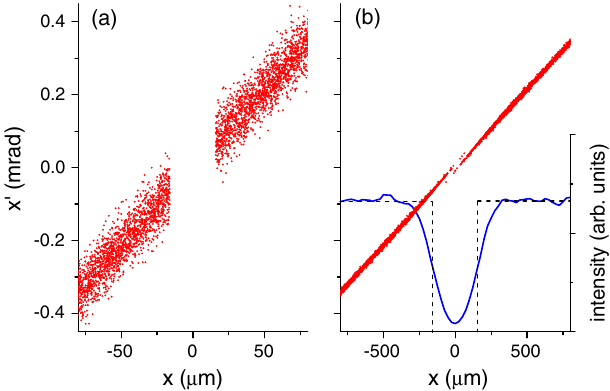
FIG. 6. Zoomed in snapshots of the x (cid:1) x 0 trace space of the beam (a) just blocked by a 32 (cid:1) m grid bar and (b) at the beam profile screen 2.1 m after the grid. In (a) the beam has a uniform density along x and a Gaussian distribution in x 0 with an rms size of 40 (cid:1) rad . The slope of the x (cid:1) x 0 band magnifies the bar image by a factor of 10. In the inset of (b) we show the shadow image of the grid bar by an ideal point source (dashed black) and the density profile of a realistic beam (solid blue).